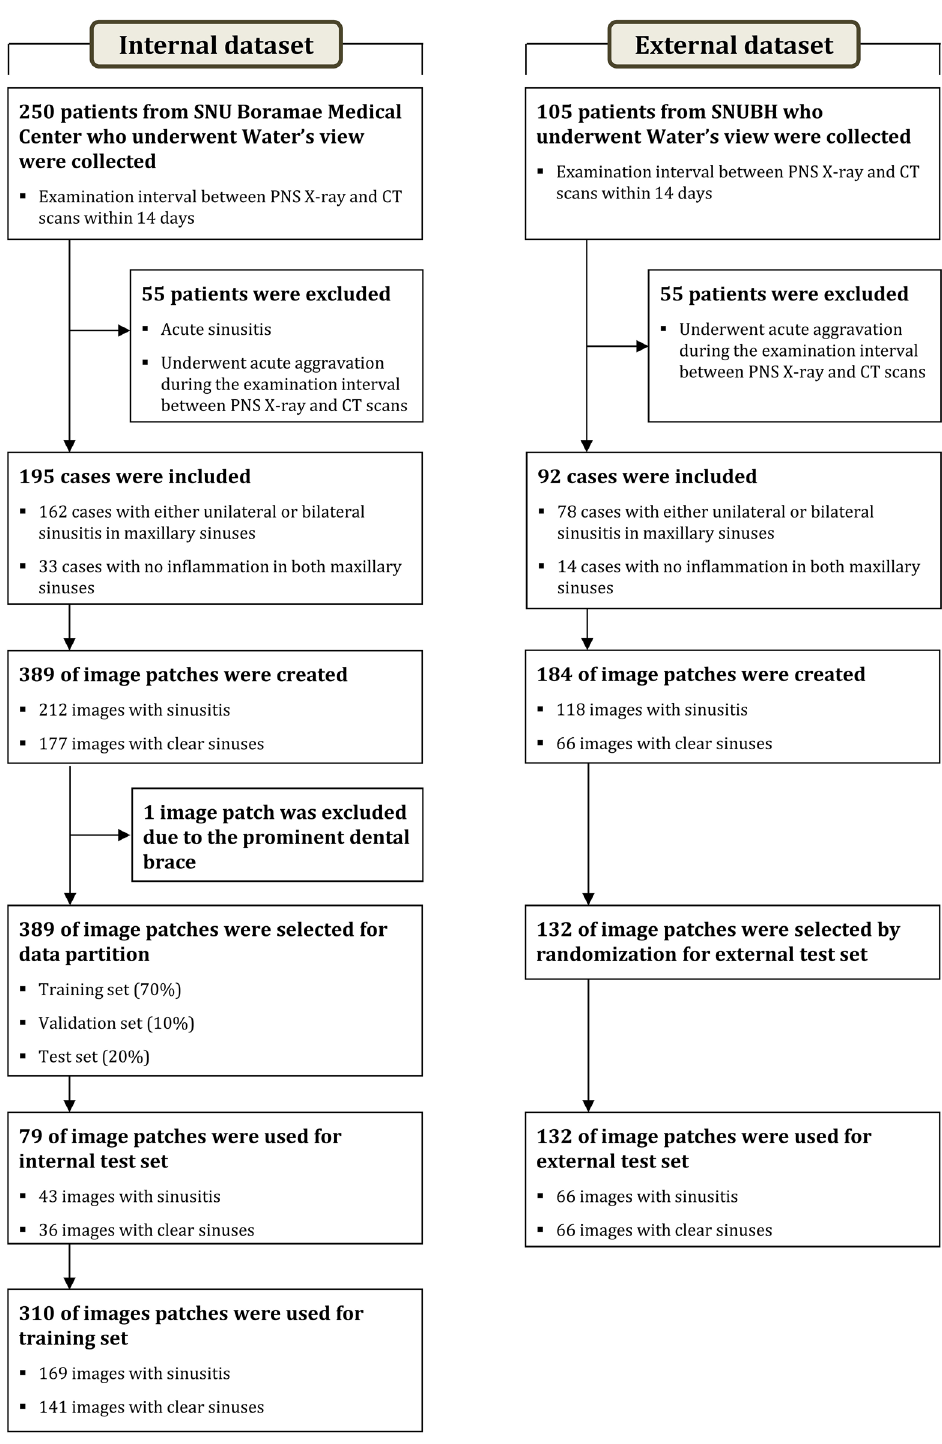
Figure 3. Flowchart of the inclusion and exclusion criteria of this